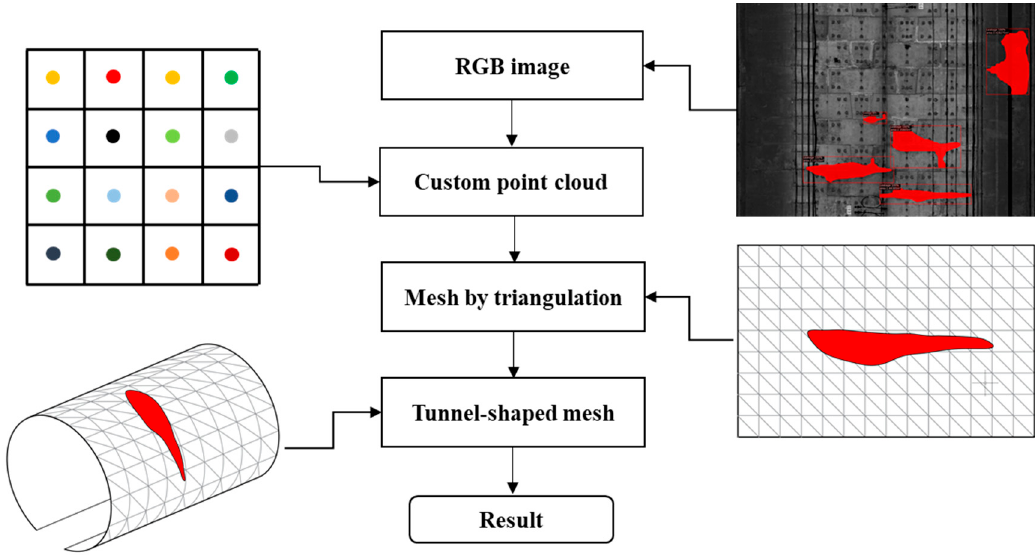
Figure 16. Workflow of the 3D tunnel surface reconstruction including water leakage information.